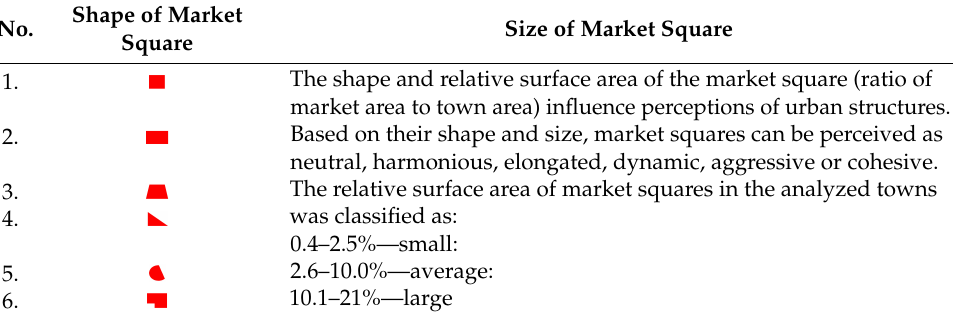
Table 3. Shape and size of market squares in the studied